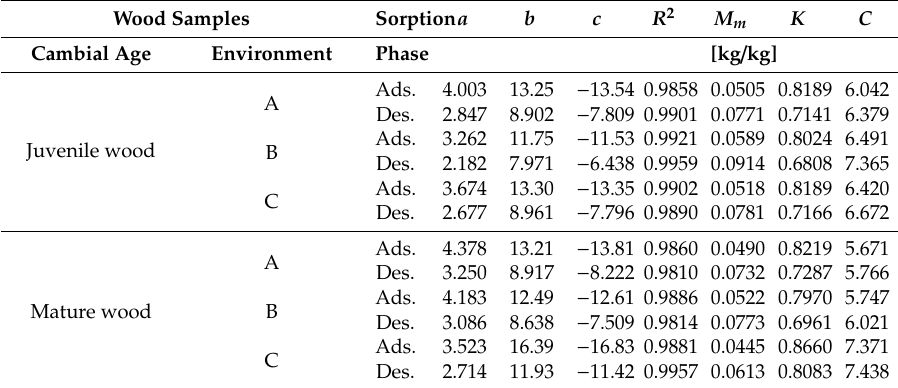
Figure 6. Plotted experimental data (points) and fitted curves (lines) by Equation (2) of the ratio relative humidity (RH)/EMC versus air relative humidity for adsorption and desorption at 20 °C of juvenile lime ( Tilia cordata Mill.) wood (tree growth in the forest (A)). Table 7. Estimated coefficients of the sorption GAB model for juvenile and mature lime ( Tilia cordata Mill.) wood.